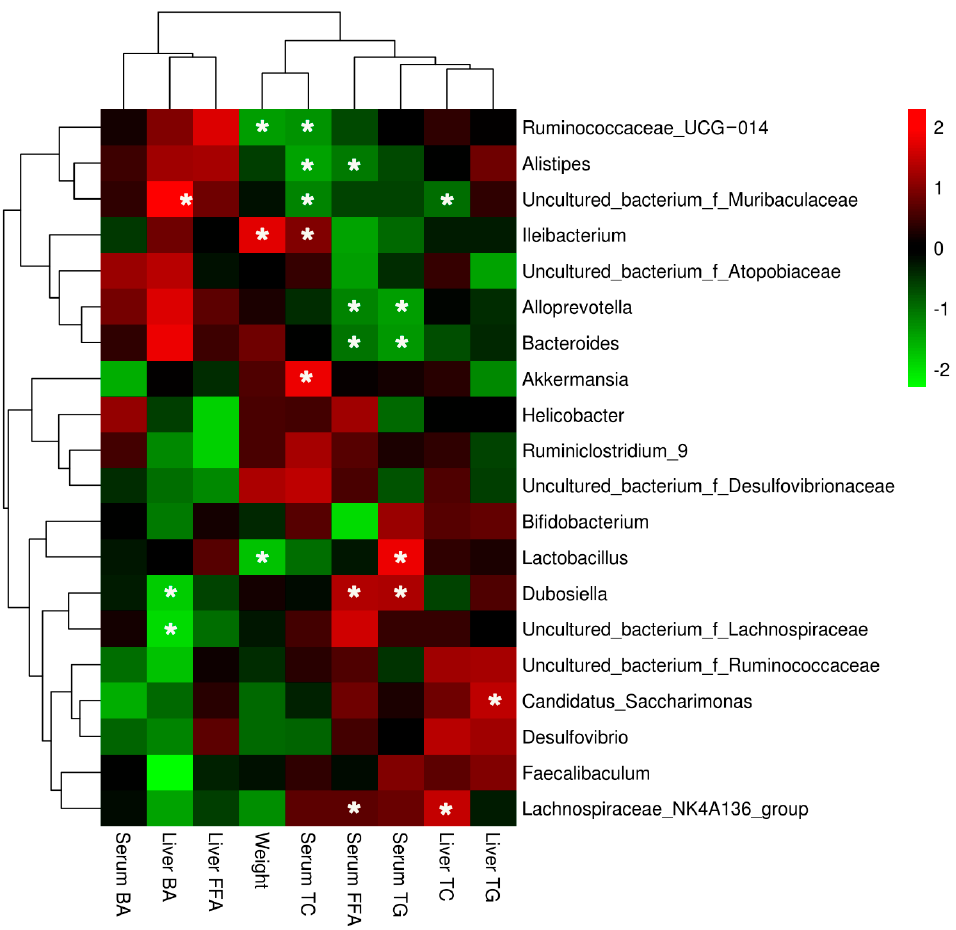
Figure 6. The heatmap of correlation analysis between physiological parameters and phyla at the genus level. TC, total cholesterol; TG, triglyceride; BA, bile acid; FFA, free fatty acid. Bar on the right represents positive correlation (shown in red) and negative correlation (shown in green) between physiological parameters and phyla. *, p < 0.05.